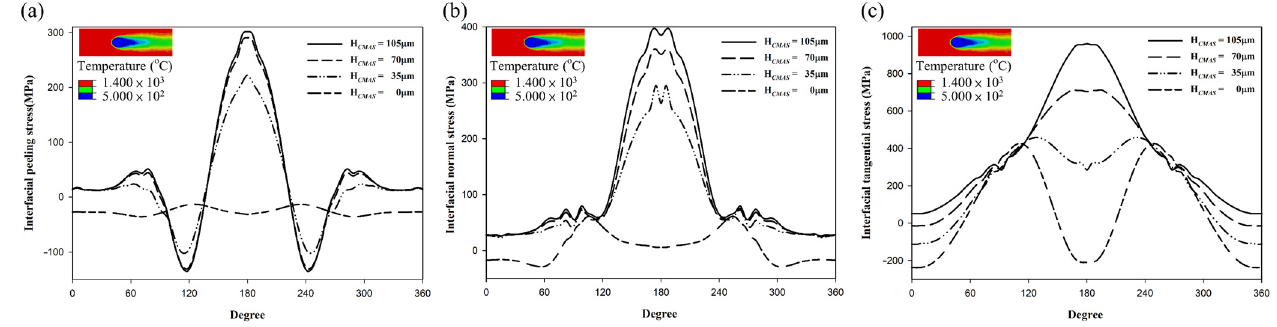
Figure 12. ( a ) Peeling stress, ( b ) interfacial normal stress, and ( c ) interfacial tangential stress along the BC top surface around the cooling hole along interfaces with different penetration depths.